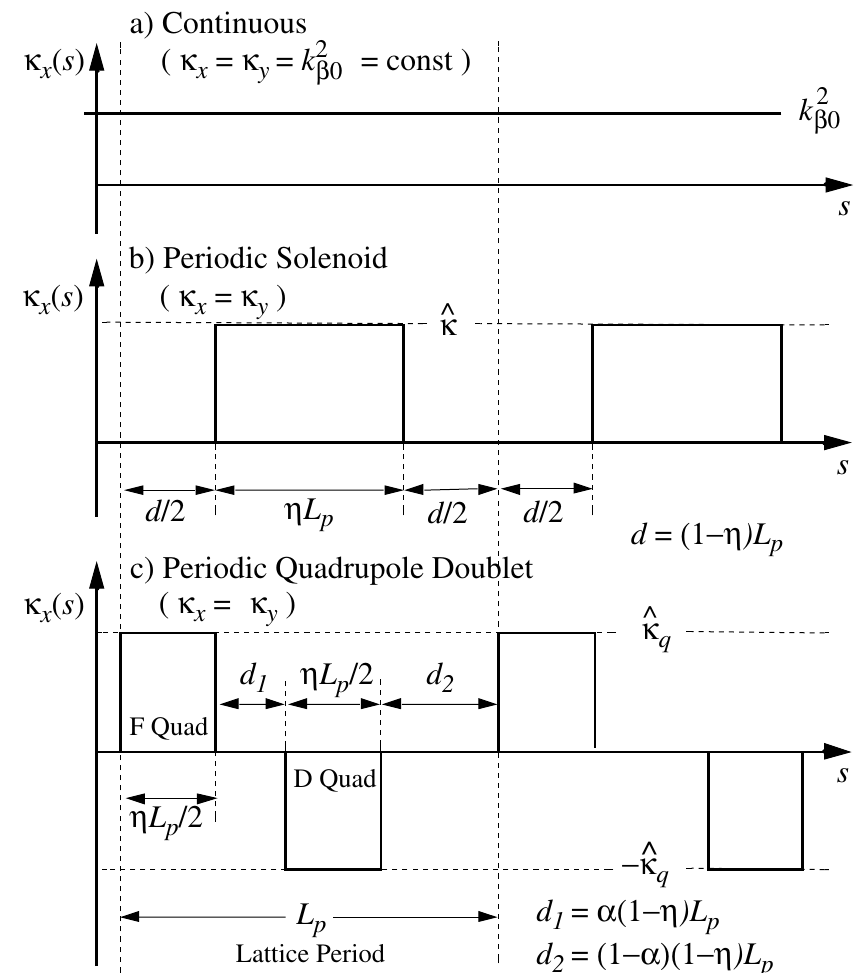
FIG. 2. Linear focusing functions in the x plane for (a) continuous focusing, (b) periodic solenoidal focusing, and (c) periodic quadrupole doublet